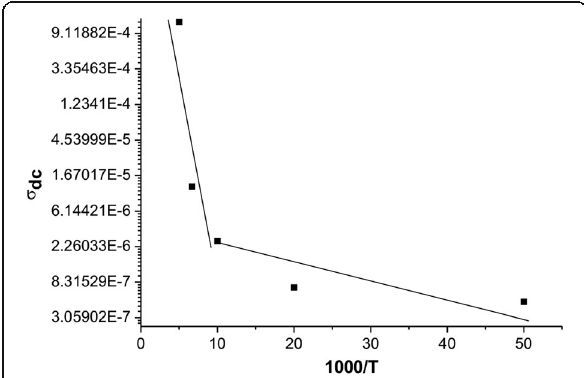
Fig. 13 Dependence DC conductivity of inverse temperature (Arrenius